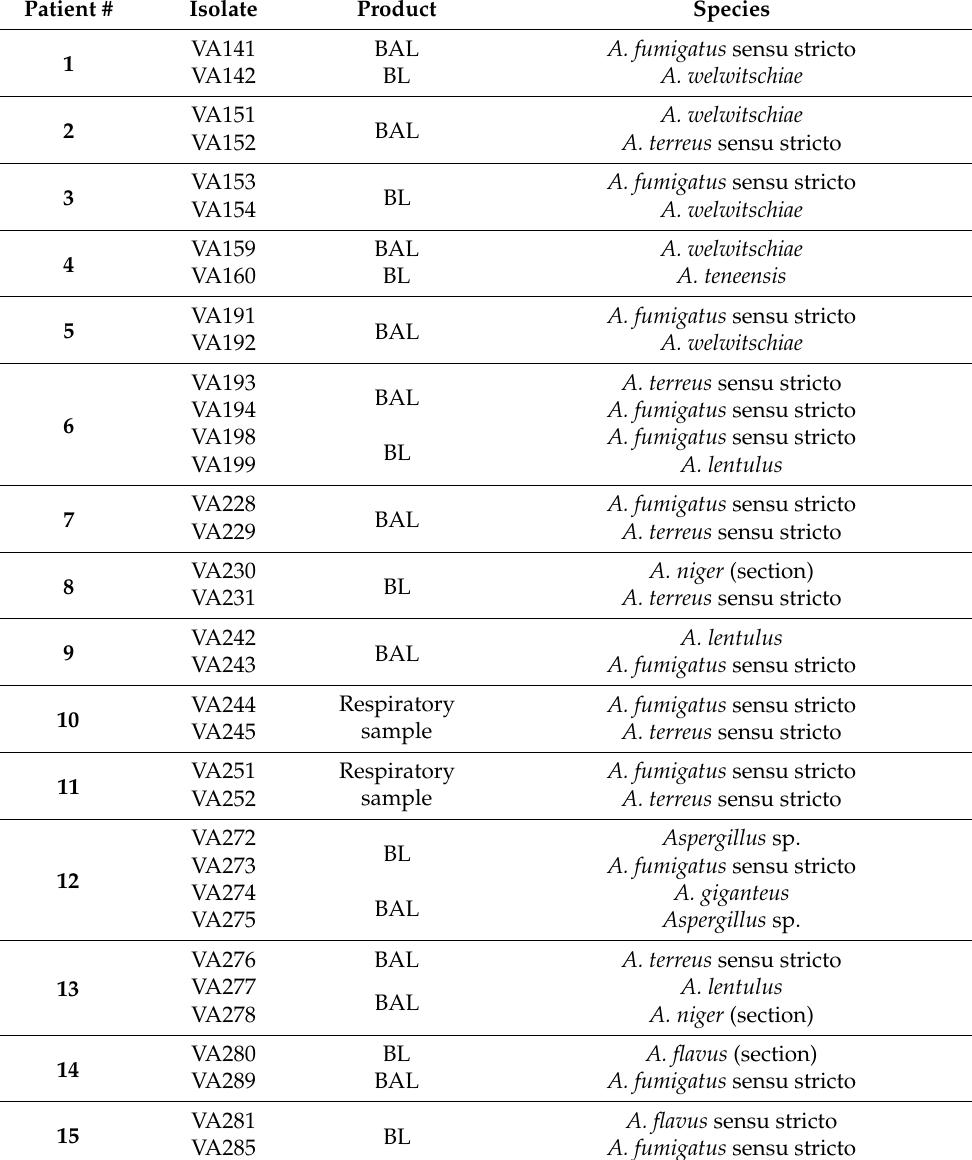
Table 2. Patients infected/colonized by more than one Aspergillus species. Patient